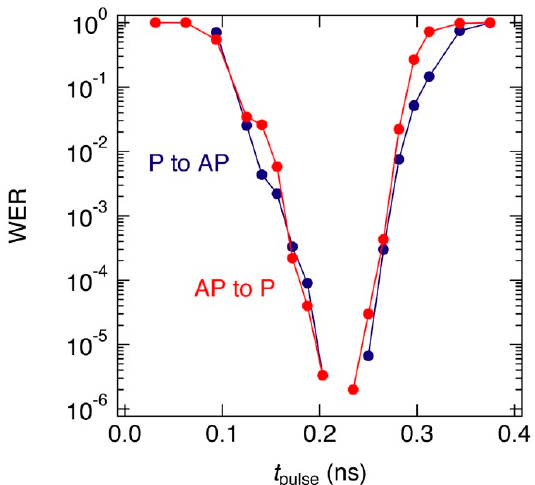
Figure 18. Example of the optimized WER as a function of t pulse observed in a perpendicularly- magnetized MTJ consisting of Ta / (Co 50 Fe 50 ) 80 B 20 / MgO / reference layer. The blue and red symbols represent the WER of parallel (P) to antiparallel (AP) and AP to P switching, respectively. Reprinted figure with permission from [109], Copyright 2019 by the IOP Publishing Ltd.